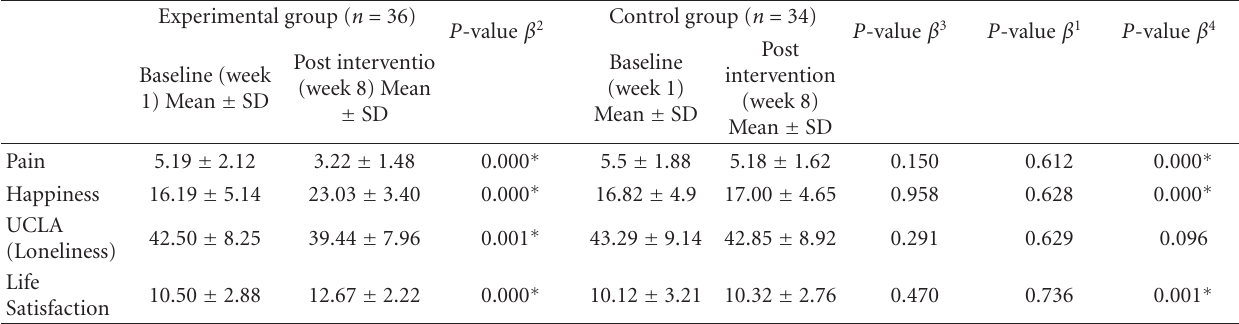
Table 2: Comparison of experimental & control groups: baseline (week 1) versus postintervention (week